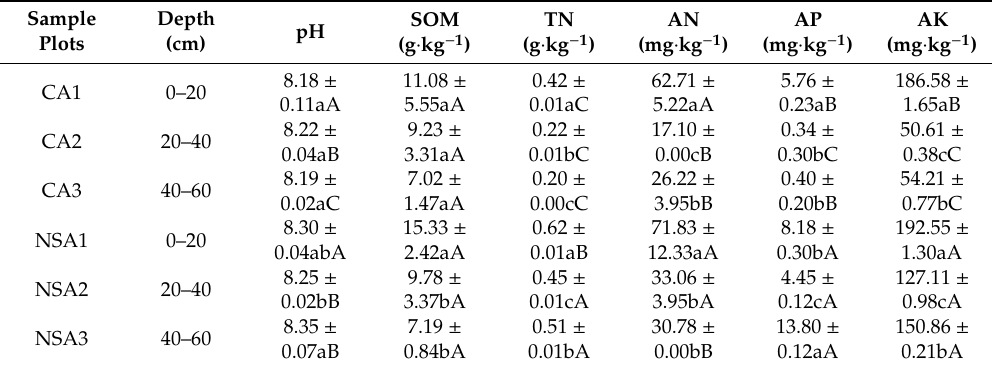
Table 2. Soil properties at di ff erent depths and di ff erent sample